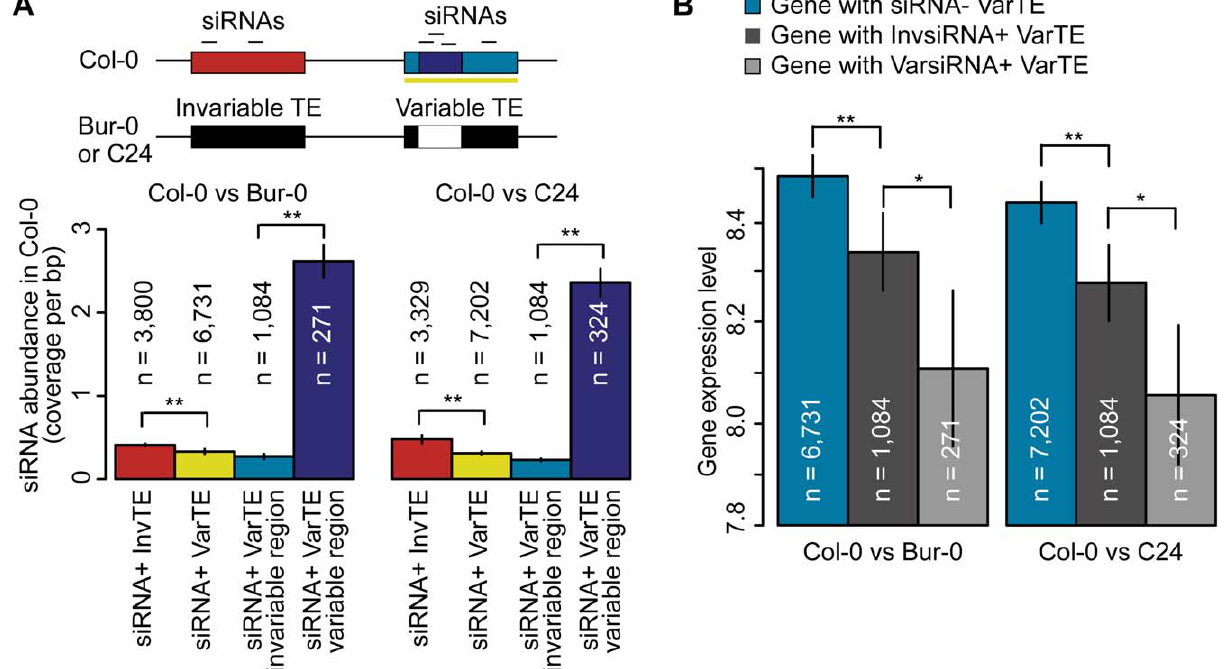
Figure 6. siRNA–targeting of VarTEs and the effect on proximal gene expression. (a) Upper panel depicts siRNA-targeting of variable and invariable regions of VarTEs defined between Col-0 and Bur-0 or C24. Lower panel shows abundance of Col-0 siRNA in siRNA + InvTEs (red) and siRNA + VarTEs (yellow) between Col-0 and Bur-0 or C24. Within siRNA + VarTEs, the abundance of Col-0 siRNA was compared between invariable (cyan) and variable regions (navy). MWU [InvTE/VarTE] p , 2 6 10 2 16 for Col-0 versus Bur-0/C24. MWU [variable/invariable regions of VarTEs] p[Col-0/Bur- 0]=1 6 10 2 5 , p[Col-0/C24] , 2 6 10 2 16 (b) VarTE + genes were divided into subgroups based on whether the closest proximal TE was siRNA 2 (cyan), InvsiRNA + (dark gray) or VarsiRNA + (light gray). The average expression level of each gene group is shown. MWU [siRNA 2 VarTE + /InvsiRNA + VarTE + ] p[Col-0/C24]=0.01, p[Col-0/Bur-0]=0.01; MWU [siRNA 2 VarTE + /VarsiRNA + VarTE + ] p[Col-0/C24]=9 6 10 2 5 , p[Col-0/Bur-0]=0.003; MWU [VarsiRNA + VarTE + /InvsiRNA VarTE + ] p[Col-0/C24]=0.01, p[Col-0/Bur-0]=0.04; *=p , 0.05, **=p , 0.01. Standard errors are shown.